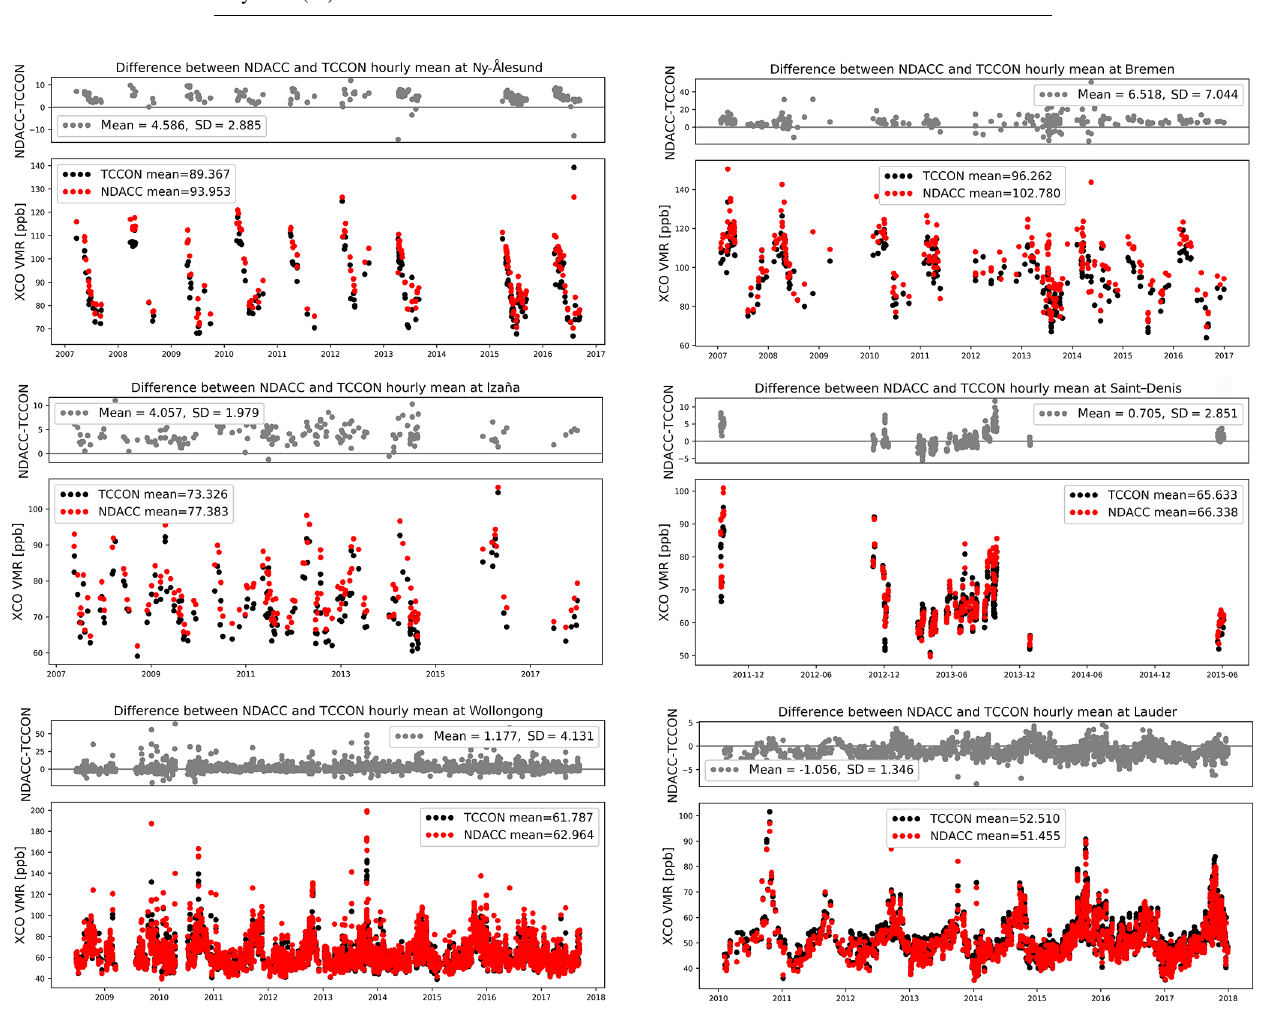
Figure 1. The time series of the TCCON and NDACC X CO measurements, together with their differences in parts per billion. Note that the range of the y axes is different at each site due to a large variation in CO in the